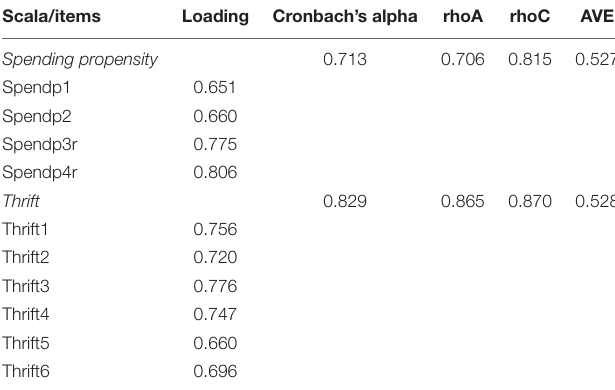
TABLE 3 | Assessment of convergent validity and internal consistency reliability.